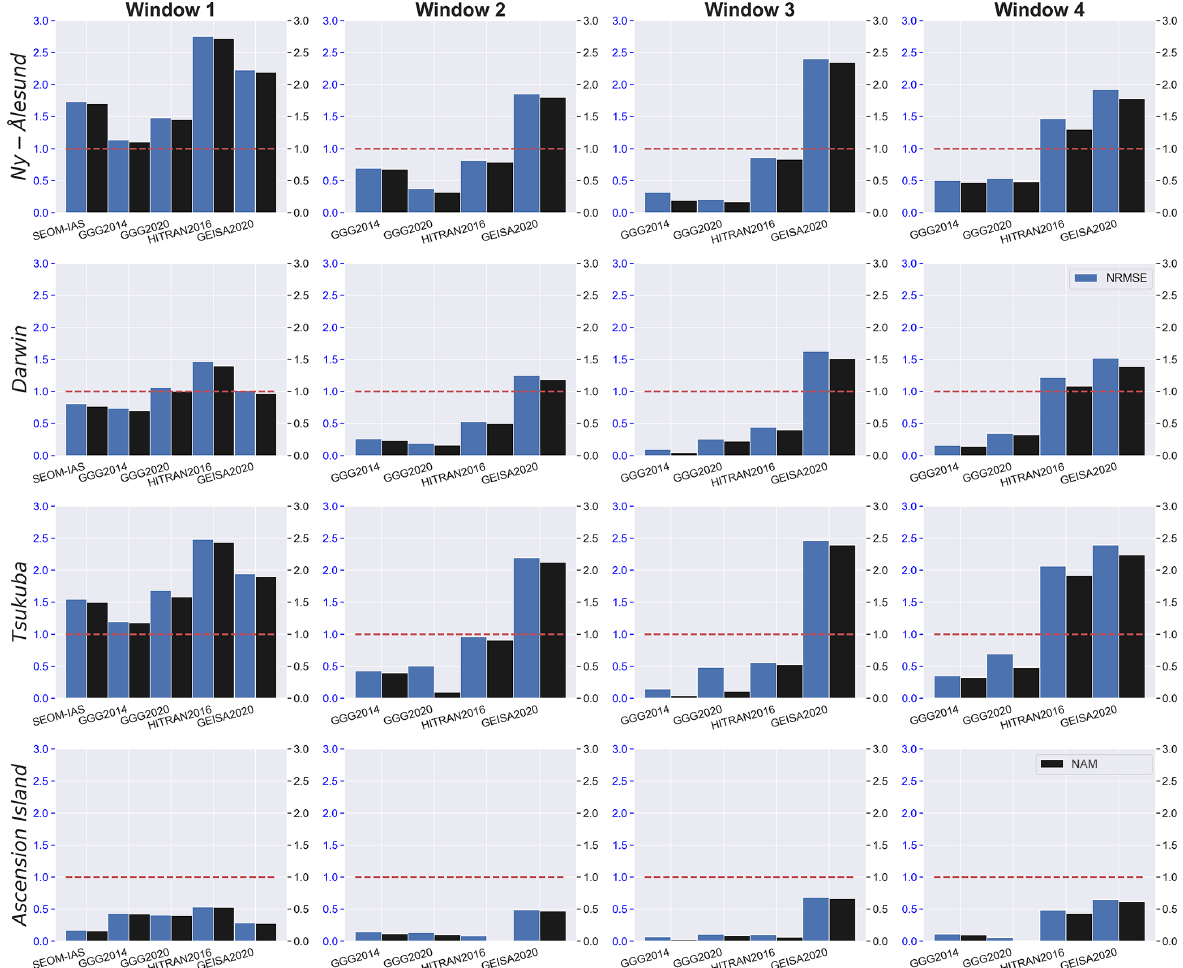
Figure 8. Bar plots indicating NRMSE and normalised absolute mean residual difference values for 12 CH 4 retrievals from each TCCON site, each window and each spectroscopic database under consideration in this study with respect to the original TCCON methane retrieval window. Each row shows data from each TCCON site, as indicated by the y -axis titles, and each column shows results from each window, as indicated by the column title. Each subplot shows the NRMSE (the blue bars, magnitude shown by the left-hand y axis) and NAM (the black bars, indicated by the right-hand y axis) values for each spectroscopic database as indicated by the x axis. The horizontal dashed red lines indicated the magnitude of 1, the value where we assume the bias values to be